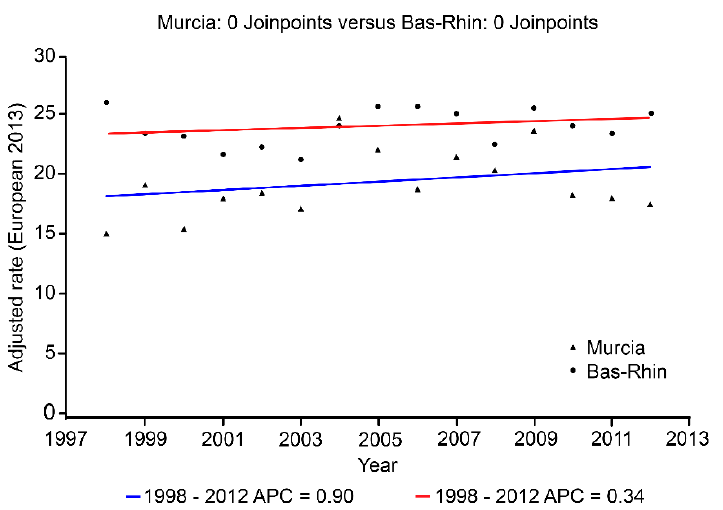
Figure 2. Joinpoint analysis of age ‐ adjusted incidence rates (per 100,000) of type I endometrial carcinoma in the Region of Murcia and the Bas ‐ Rhin area, 1998–2012 period. APC: Annual Percent Change.